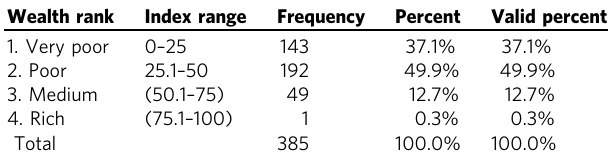
Table 4 Wealth rank of survey